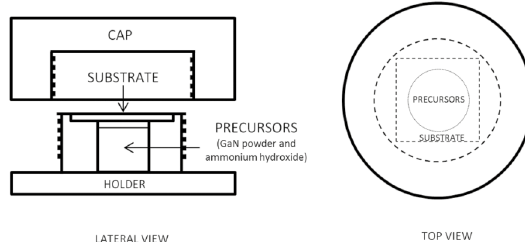
Figure 1. Scheme of the graphite cell. Semi-hermetic container constituted of two pieces: 1) a substrate holder and powder container and 2) a cap.